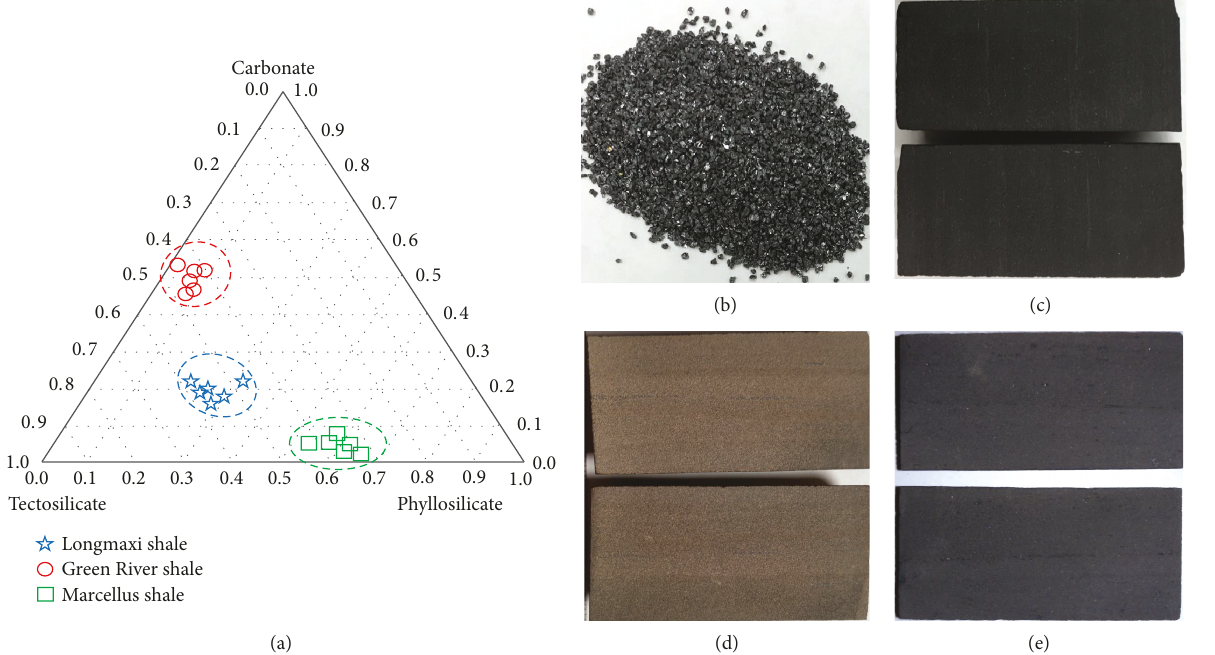
Figure 1: (a) Mineralogical composition of shale samples used in experiment, (b) 20 grit silicon carbide, (c) Longmaxi shale, (d) Green River shale, and (e) Marcellus